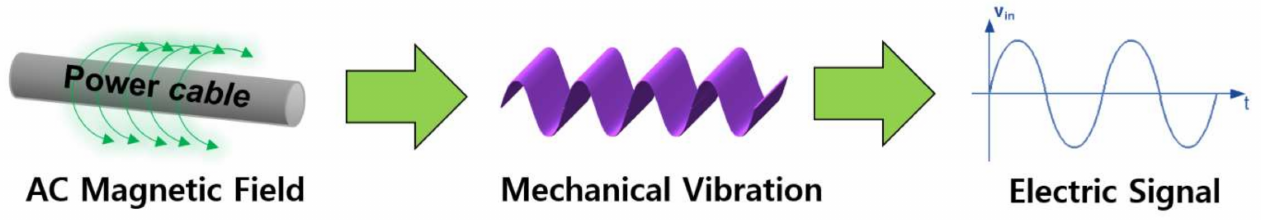
Figure 1. Operation mechanism of magneto-mechano-electric